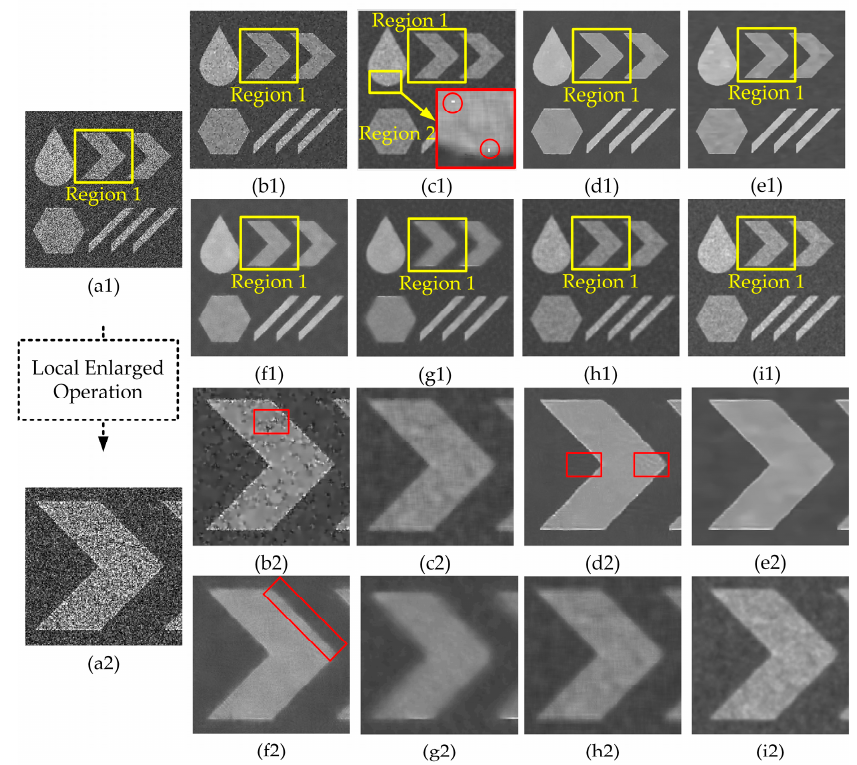
Figure 6. ( a1 ) Added single-look speckle image (the mean is 1 and the variance is 0.1). Images were filtered using ( b1 ) DPAD, ( c1 ) EnLee, ( d1 ) SAR-BM3-D, ( e1 ) FANS, ( f1 ) PPB, ( g1 ) DnCNN, ( h1 ) NL-means, and ( i1 ) MDLPIA-NLM filters. ( a2 – i2 ) Locally enlarged images of region 1 of ( a1 – i1 ), respectively. The red box and circle are areas for further observation.